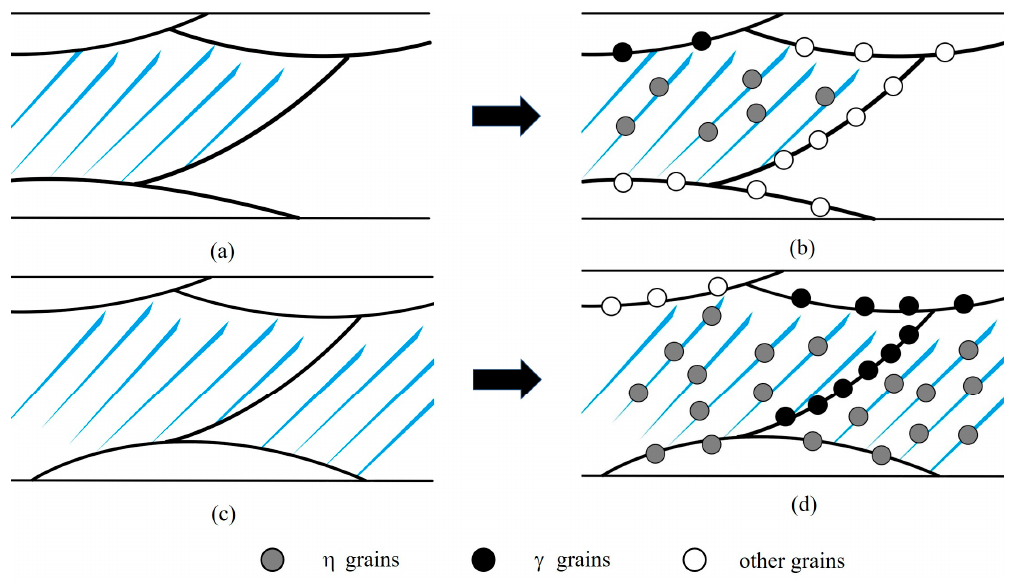
Figure 6. Proportion of γ , η and λ oriented grains in all recrystallized grains after annealing at 900 °C for 30 s (deviation angle: 15°).